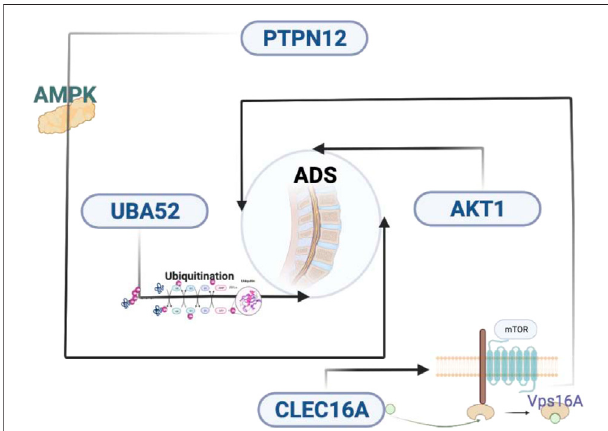
FIGURE10| Key genesand molecularmechanisms thatmay berelated to ADS. ADS, adult degenerative scoliosis; lncRNAs, long noncoding RNAs; mRNAs, messenger RNAs; RNA-seq, RNA sequencing; PPI, protein – protein interaction;NP:nucleus pulposus; IDD,intervertebral discdegeneration; qRT-PCR: quantitative RT-PCR; IVD, intervertebral disc; DE, differentially expressed; BMI, body mass index; PBS, phosphate-buffered saline; FPKM, fragments per kilobase of exon model per mapped reads; CC, cellular composition; MF, molecular function; BP, biological process; KEGG, Kyoto EncyclopediaofGenesandGenomes;FDR,falsediscoveryrate;SNPs,single nucleotidepolymorphisms;AF,annulus fi brosus;CEP,cartilaginousendplate; ECM, extracellular matrix; CEP, C-terminal elongation